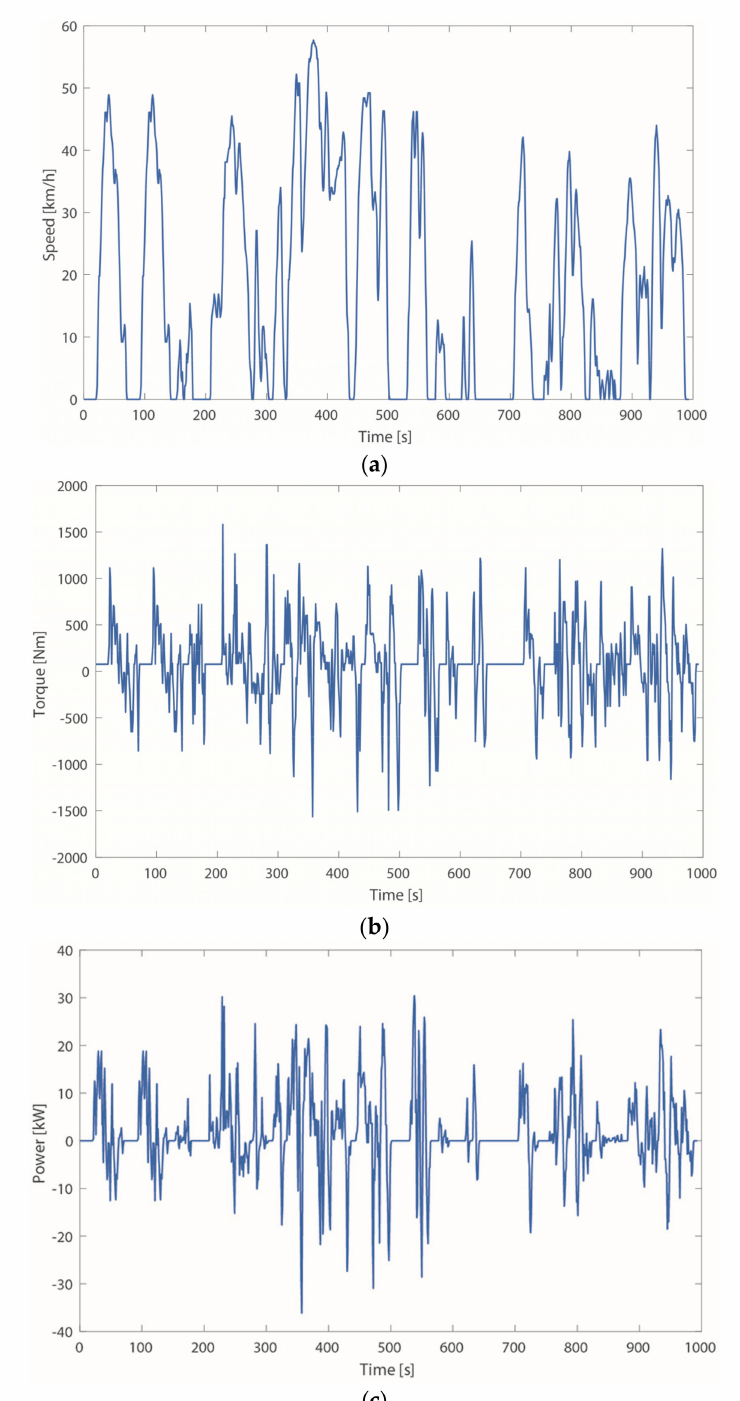
Figure 5. Load profile prescribed by the Artemis urban cycle: ( a ) speed demand; ( b ) corresponding torque; and ( c ) power